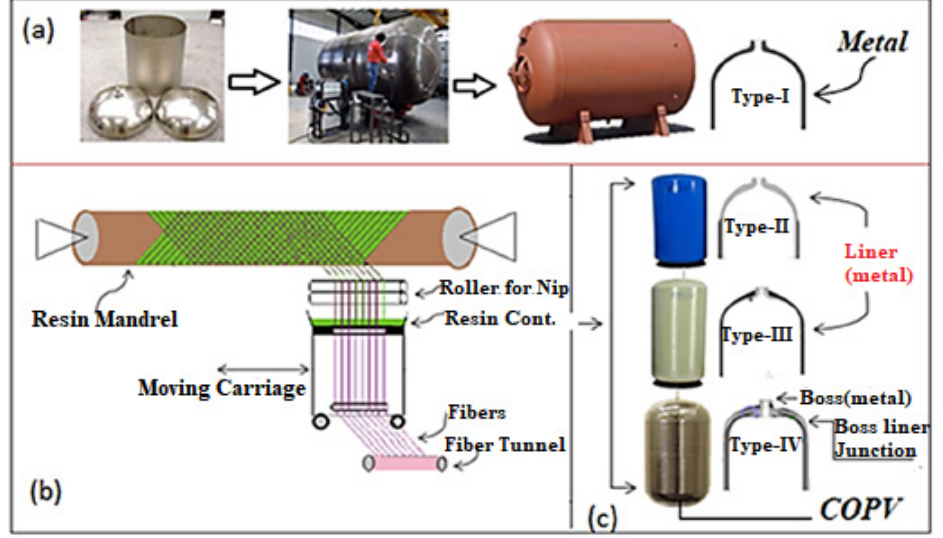
Figure 1. ( a ) Type-I Pressure vessel production method, ( b ) Filament winding layout for